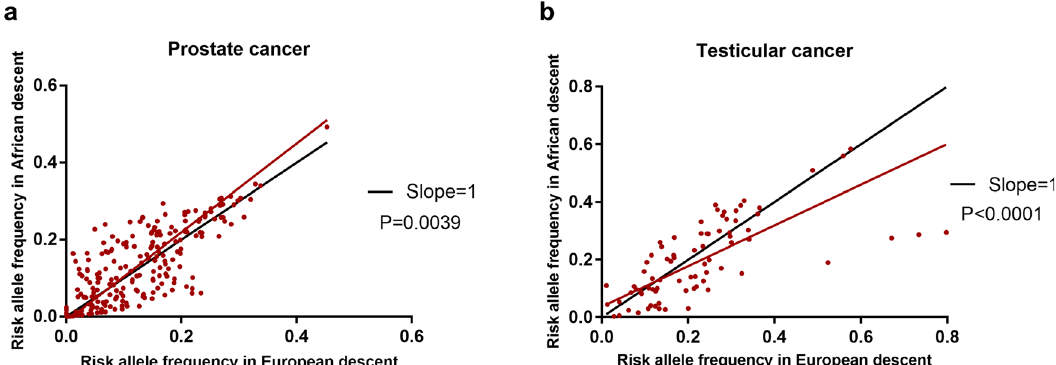
Fig. 2 Regression lines of risk allele frequencies between African and European descent for prostate and testicular cancers. a The regression line of prostate cancer data (slope = 1.152) skewed above the standard line (slope = 1) towards African population. The differences between the slopes were highly signi fi cant ( n = 226; p = 0.0039). b The regression line of testicular cancer data (slope = 0.705) skewed below the standard line slope (slope = 1) towards European population. The differences between the slopes were highly signi fi cant ( n = 79; p <